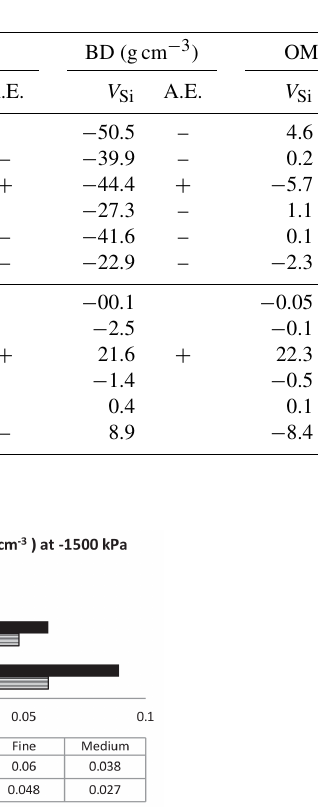
Table 4. Variation of first-order sensitivity index ( S i ) in the different textural (Tex.) classes.